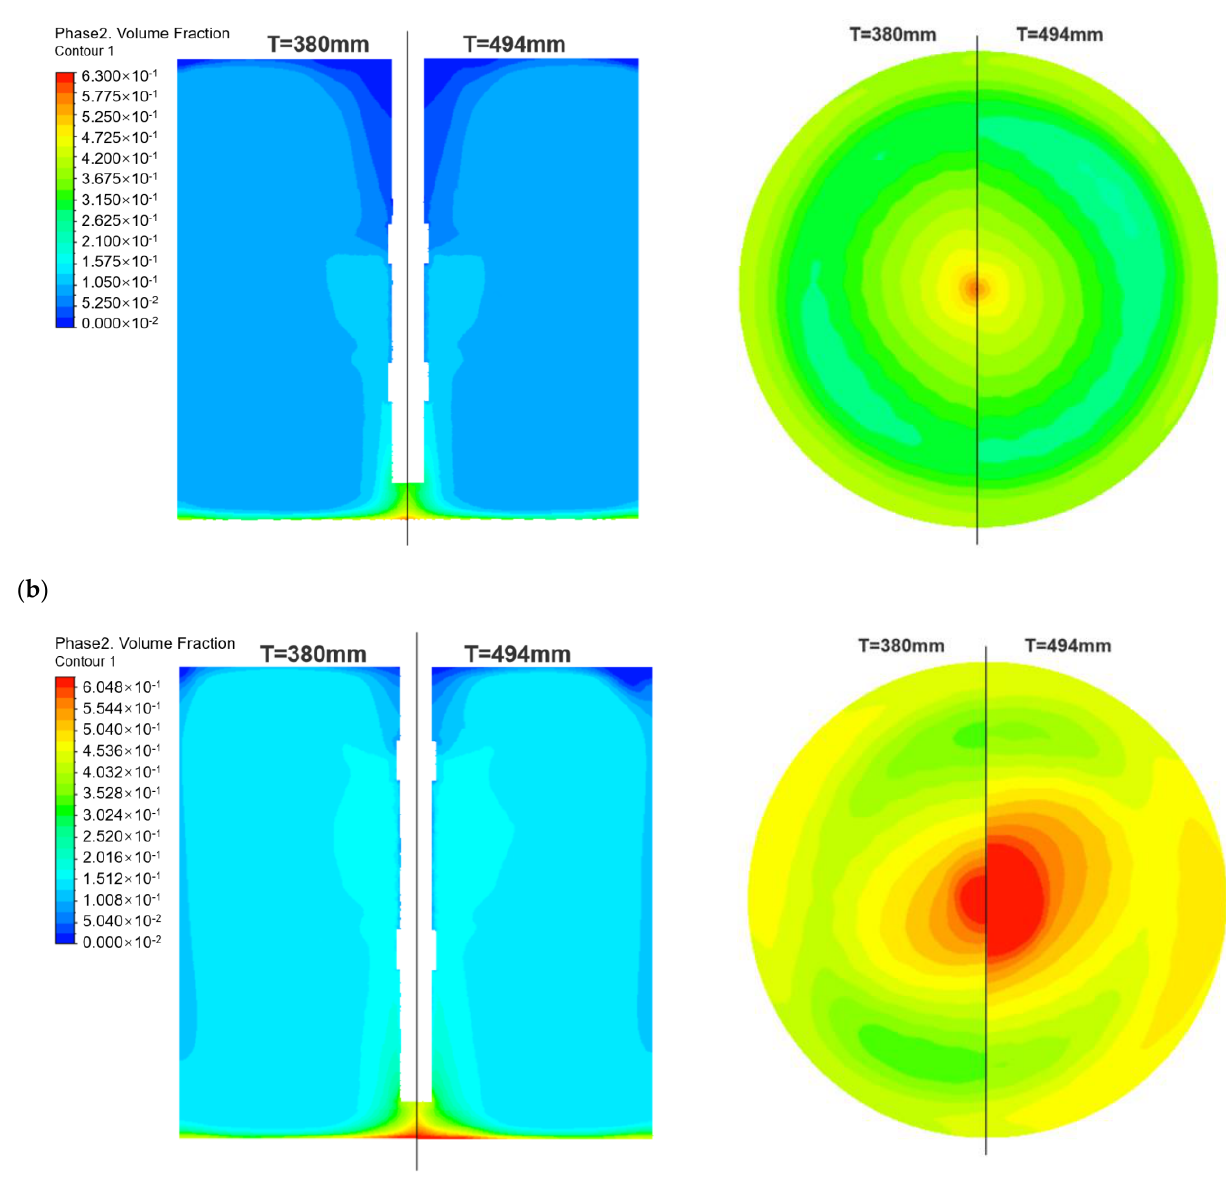
Figure 7. Comparison of solid concentration distributions scaled up based on the same blade tip linear velocity: ( a ) Co = 5% v/v ; ( b ) Co = 10% v/v ; ( c ) Co = 15% v/v .